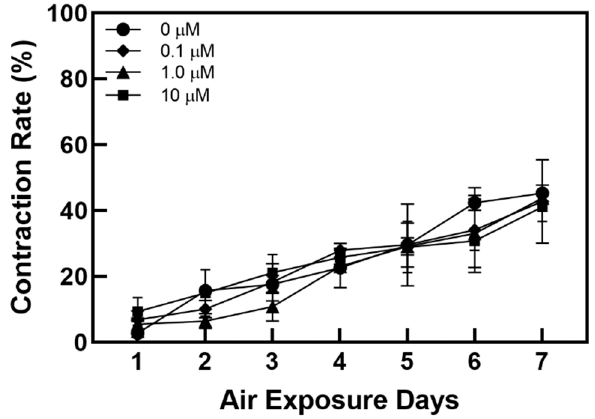
Figure 3. Variation of the contraction rate of the samples as a function of the air exposure period with the four different concentrations of coenzyme Q10.